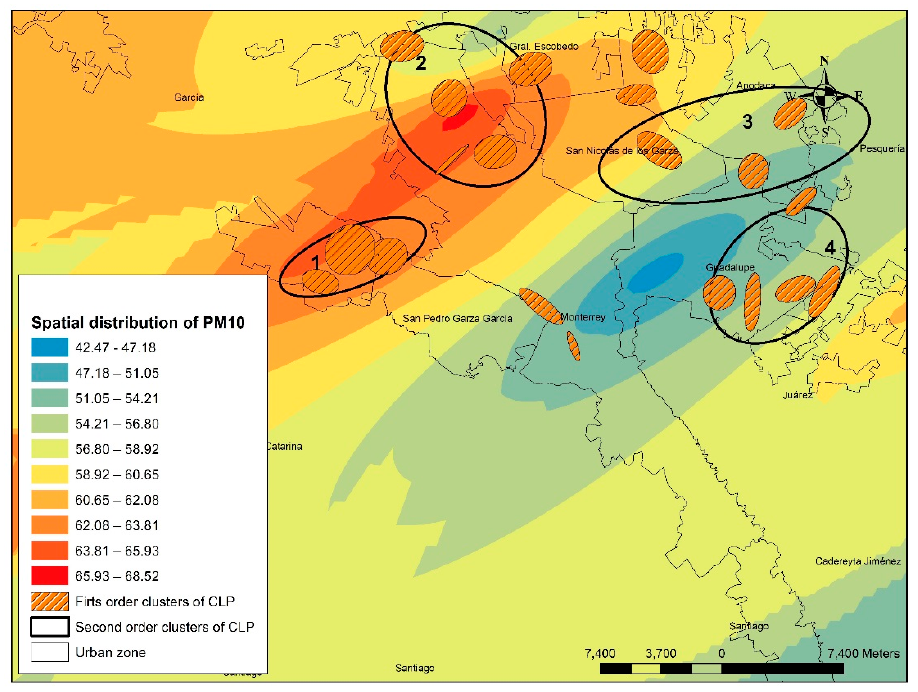
Figure 6. Spatial association of CLP cases and PM 10 .